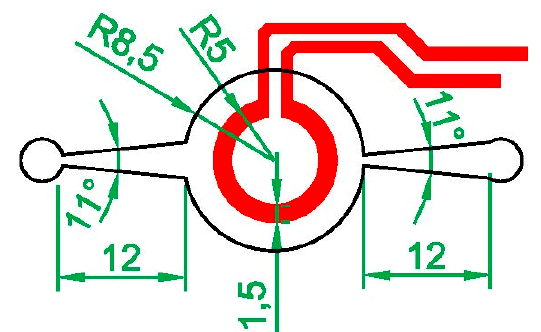
Figure 1. Schematic of the diffusor/nozzle pump. Black outline: Microfluidic channel, the depth of the channel is 250 µm; dimensions in mm. Red: Copper traces of the PCB.